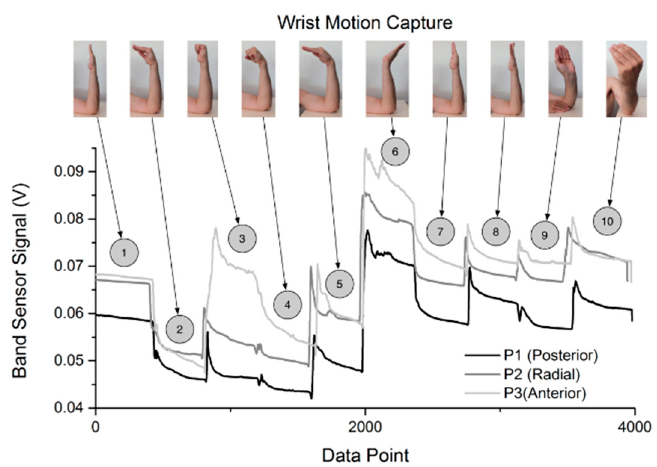
Figure 12. Motion capture of the three band sensor wrist positions (posterior, radial, anterior) displayed together.